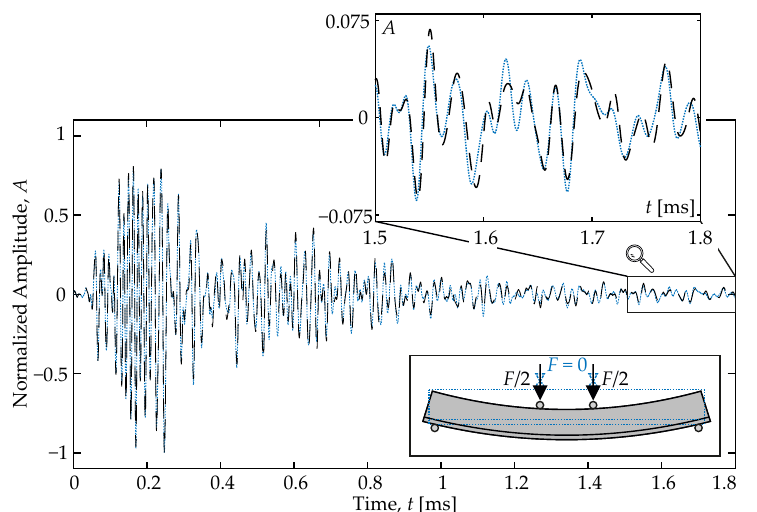
Figure 2. US measurement of the same transmitter-receiver combination, before and after an influence has